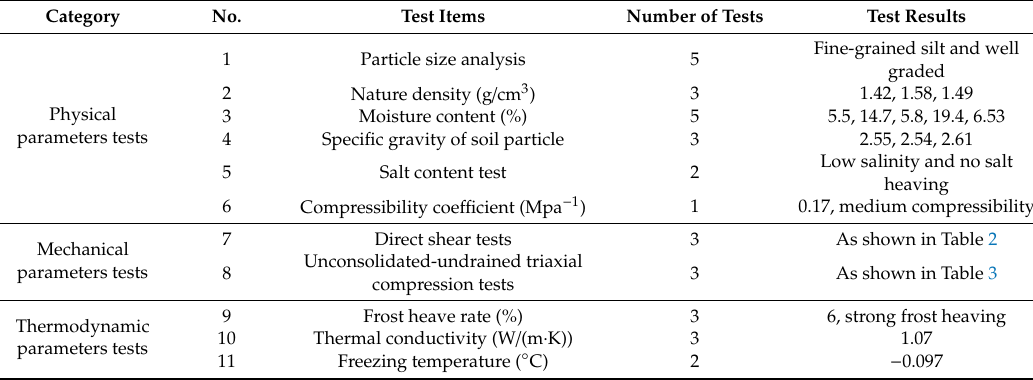
Table 1. The physical, mechanical, and thermodynamic properties of test soil.